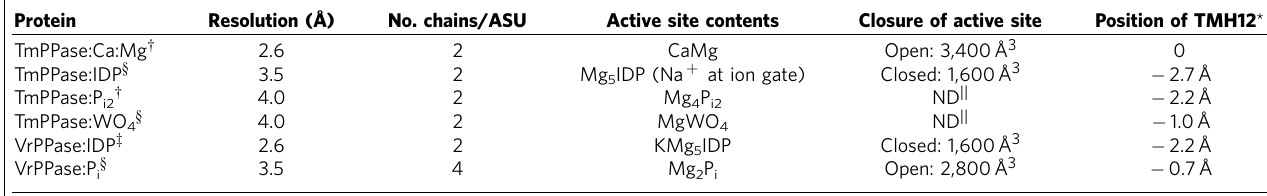
Table 1 | Structures and states of M-PPases.